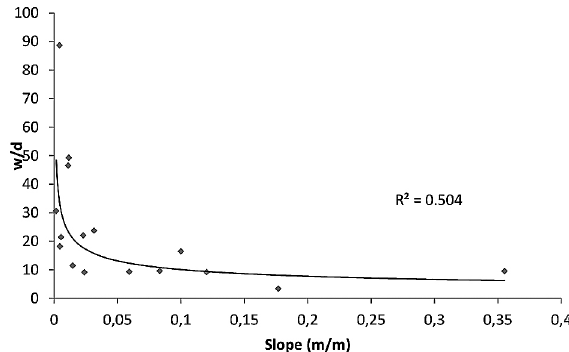
Fig. 9. As slope increases higher velocity restrict widening keeping width depth ratio